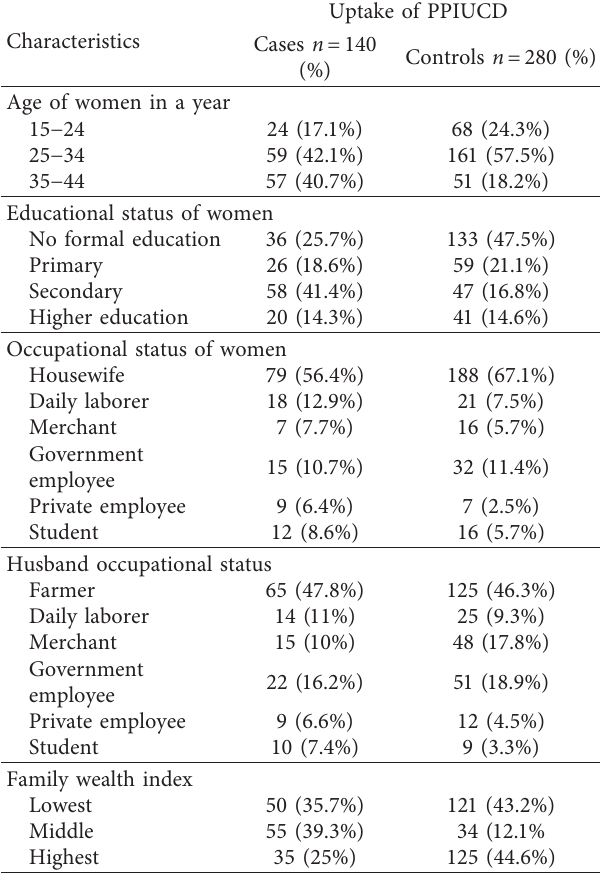
Table 1: Sociodemographic characters of respondents who gave birth in South Gondar public hospitals, Northwest Ethiopia,